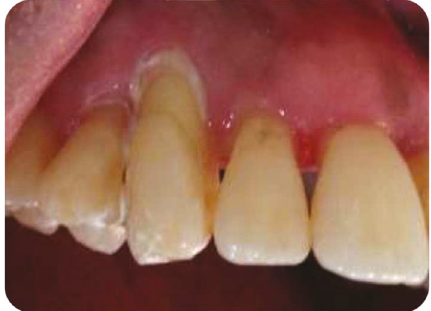
Figure 1: Purulent discharge related to number 13.